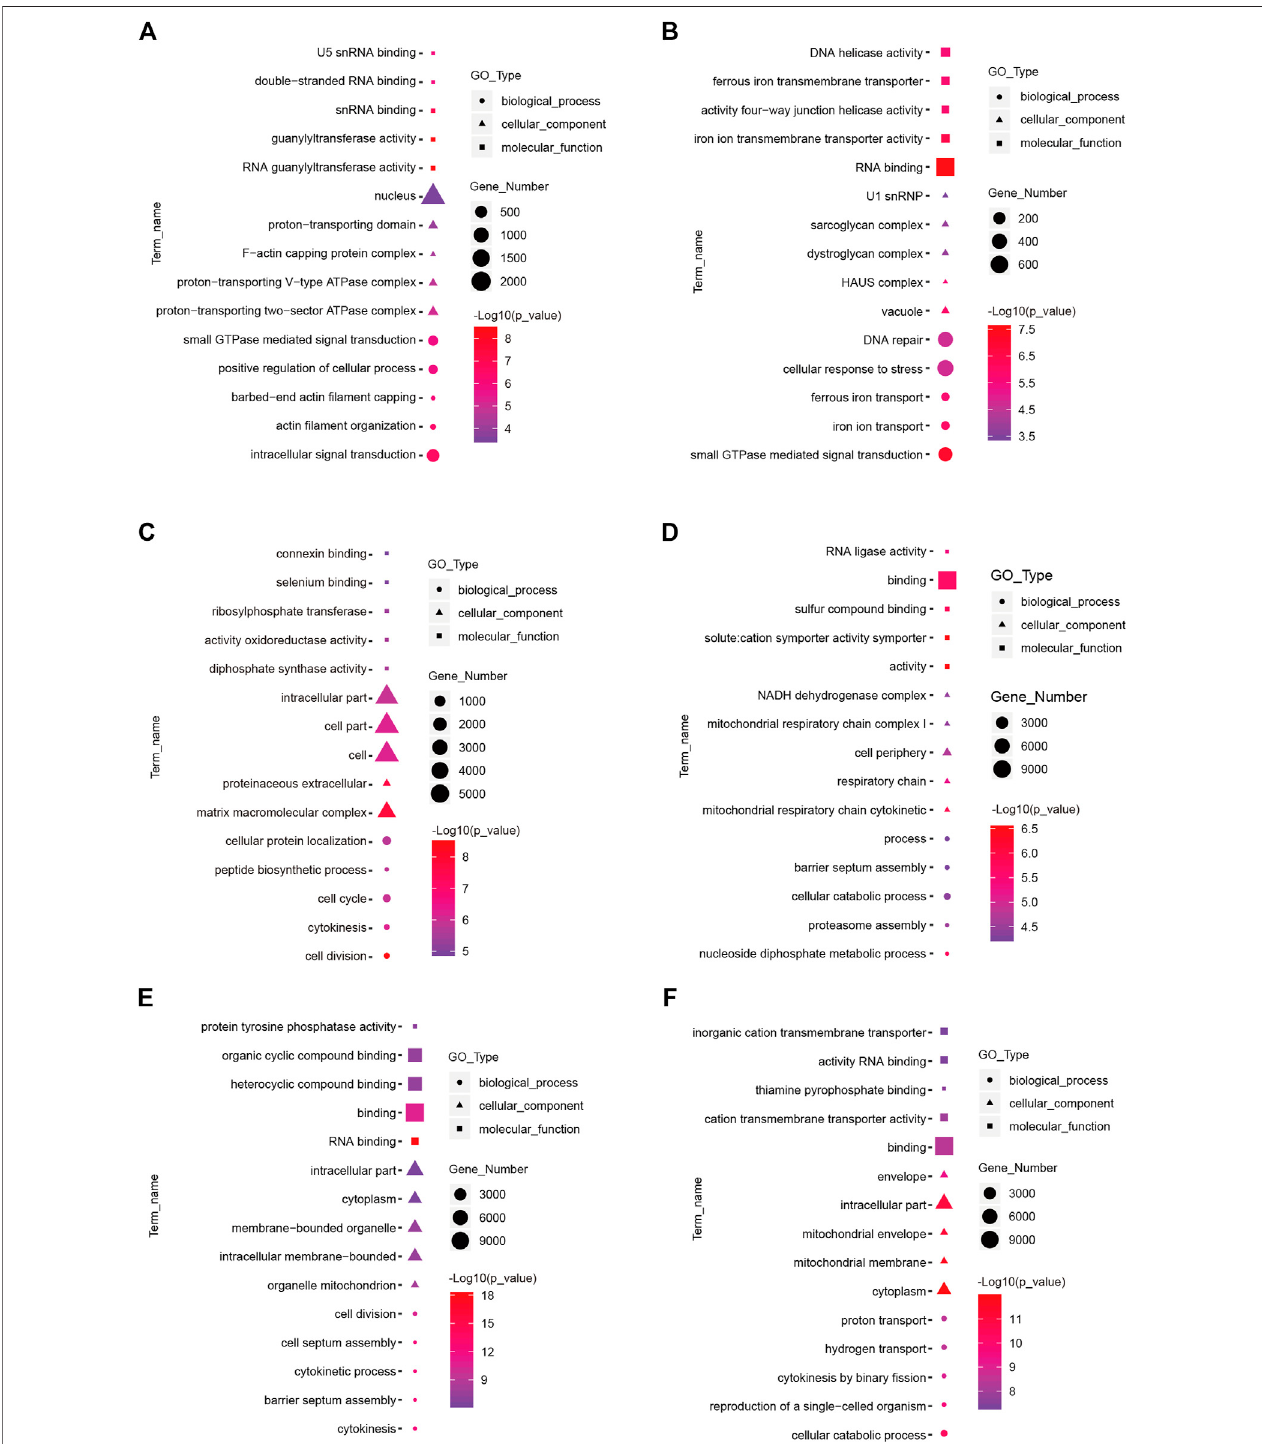
FIGURE5| TopenrichedGeneOntology(GO)termsofdifferentiallyexpressedmRNAbetweentheshortphotoperiodandlongphotoperiodinthehypothalamusof Sunite sheep. The GO terms in (A – F) are from SP42 vs. LP42, SP42 vs. SP-LP3, SP42 vs. SP-LP7, SP42 vs. SP-LP15, SP42 vs. SP-LP21, and SP42 vs. SP-LP42,